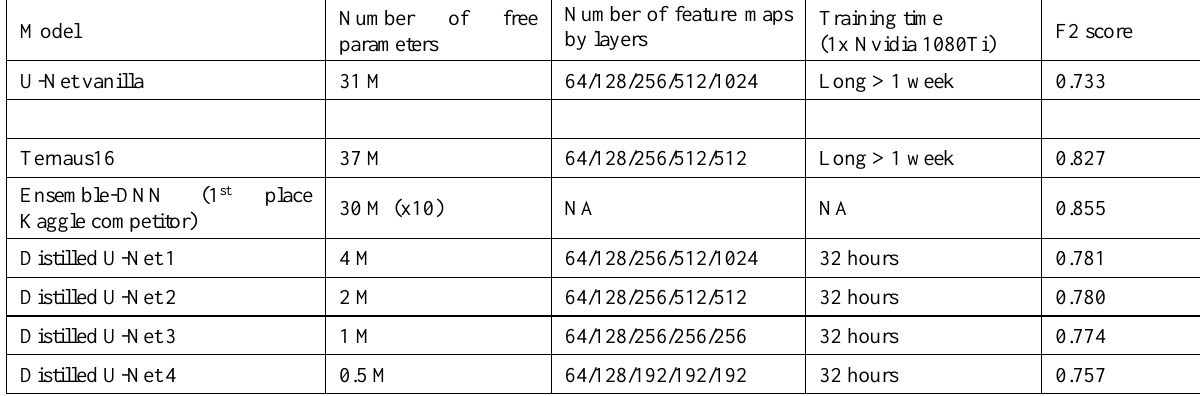
Table 1. Comparison of architecture and performances of all considered